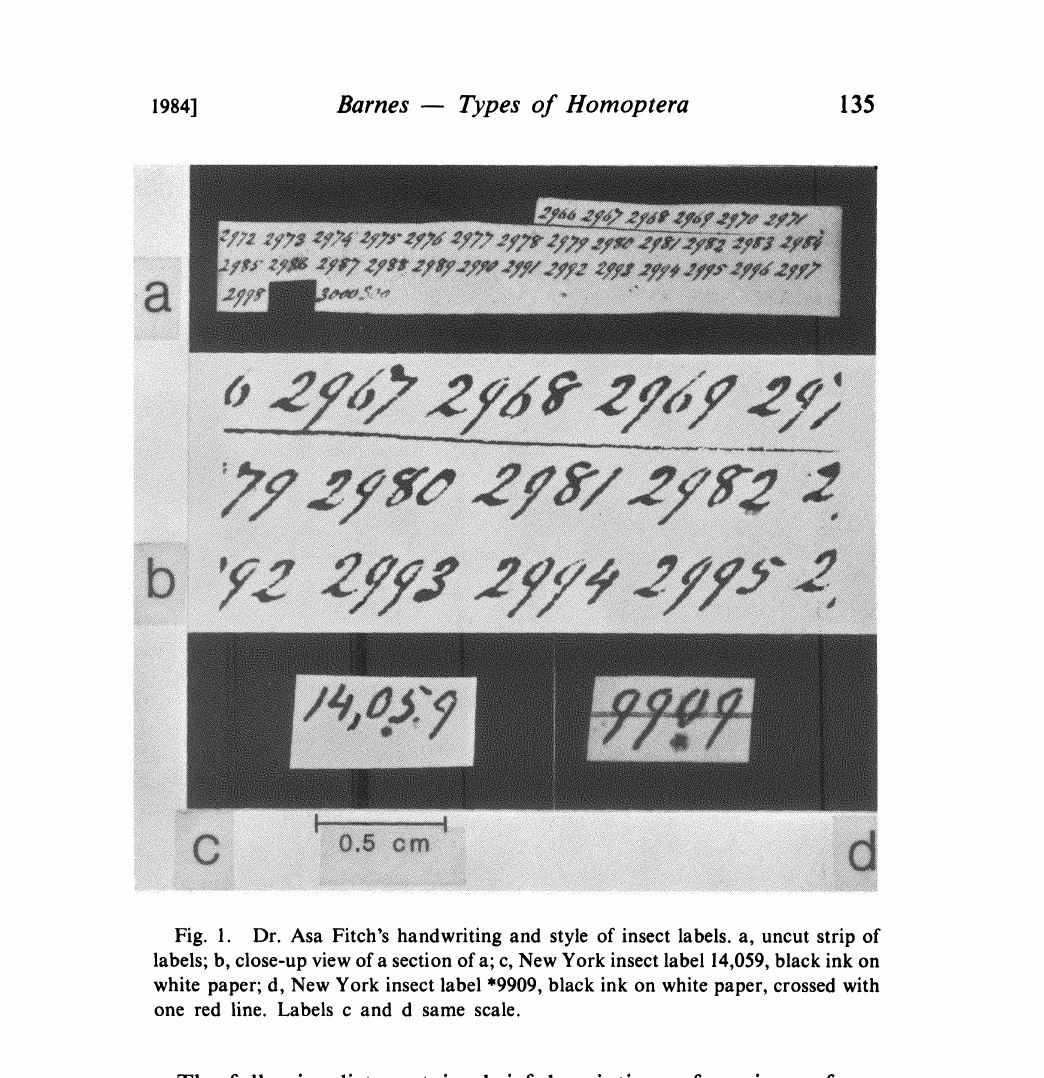
Fig. I. Dr. Asa Fitch’s handwriting and style of insect labels, a, uncut strip of labels; b, close-up view of a section of a; c, New York insect label 14,059, black ink on white paper; d, New York insect label *9909, black ink on white paper, crossed with one red line. Labels c and d same